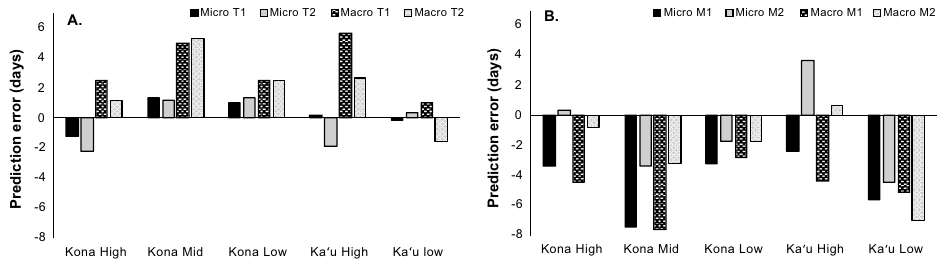
Fig 3. Difference between observed development times under field conditions (micro-temperature = branches and macro-temperature = farms) at five coffee farms on Hawai‘i Island and predicted development times (in days) under constant laboratory conditions. (A). Comparison of teneral adult development times between Jaramillo et al. [23; T1] and Giraldo-Jaramillo et al. [24; T2], (B) Comparison of mature adult development times between Jaramillo et al. [23; M1] and Giraldo-Jaramillo et al. [24; M2]. Significant differences between observed and predicted development times are indicated as follows: � = p < 0.05, �� = p < 0.01, ��� = p <